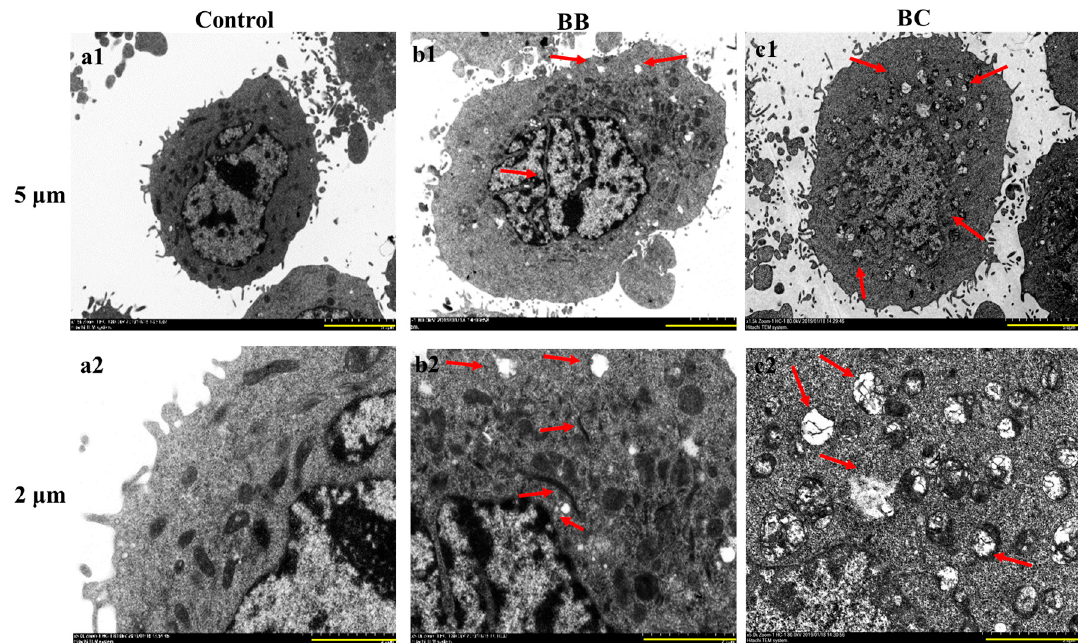
Figure 4. Effects of BB and BC on the ultrastructure in BGC-823: ( a1 , a2 ) BGC-823 cells without treatment with Brevilaterins; ( b1 , b2 ) BGC-823 cells after treatment by BB for 24 h; ( c1 , c2 ) BGC-823 cells after treatment by BC for 24 h. The arrows indicate typical changes, such as the appearance of autophagic vacuoles and nuclear membrane “folding” within the cells. The yellow lines represent a scale of corresponding size.